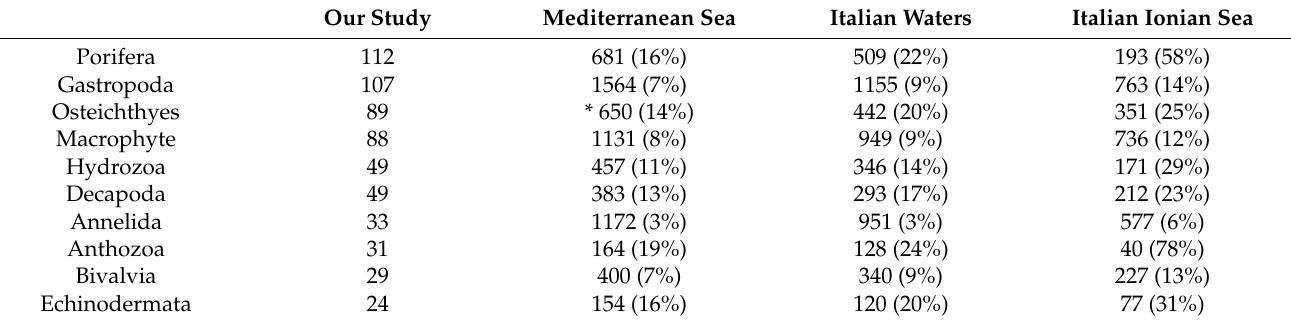
Table 2. Comparison of the results of this study with the total number of taxa in the Mediterranean Sea [7], Italian waters [60,61] and Italian Ionian Sea [60,61], for selected taxonomic groups. Numbers represent the number of taxa, while the percentage of taxa found by this study out of the total number of species known for the area is given in brackets. * this figure also includes